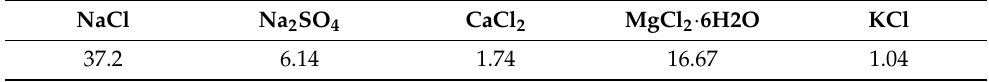
Table 2. Chemical compositions of the simulated seawater,